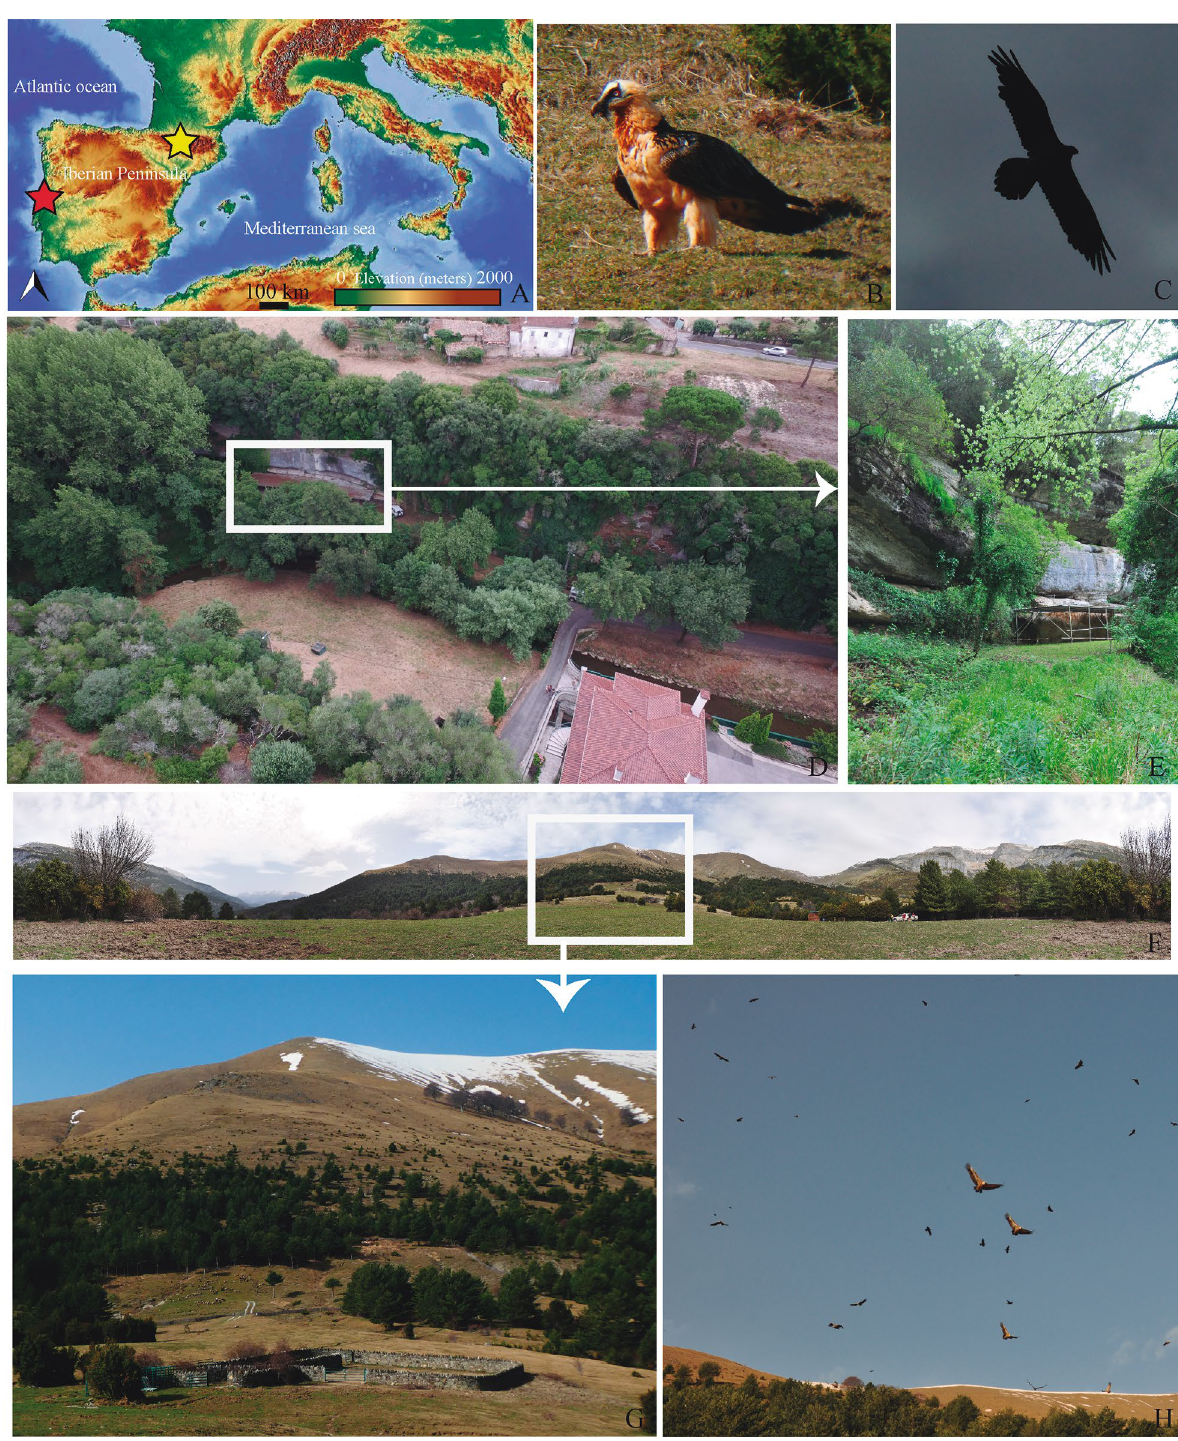
Figure 1. ( A) Map showing the location of the Lagar Velho rock shelter (red star) in Portugal and the Ordesa and Monte Perdido National Park (yellow star) in Spain. Map extracted from OpenStreetMap (CC BY-SA). OpenStreetMap© licensed under ODdL 1.0 (https:// www. opens treet map. org/ copyr ight) by the OpenStreetMap Foundation (OSMF). ©OpenStreetMap contributors (https:// www. opens treet map. org/). The licence terms can be found on the following link: http:// creat iveco mmons. org/ licen ses/ by- sa/2. 0/ (accessed on 21 May 2022). ( B ) and ( C ) Bearded vultures in the supplementary feeding station located in the Ordesa and Monte Perdido National Park (PNOMP). ( D ) and ( E ) Lagar Velho rock shelter (D: Aerial view of the shelter). ( F ) and ( G ) General view of the supplementary feeding station located in the PNOMP where current scats of bearded vulture were collected. ( H ) Vultures (mostly griffon, but also bearded and modern Egyptian vultures) circling over the feeding station